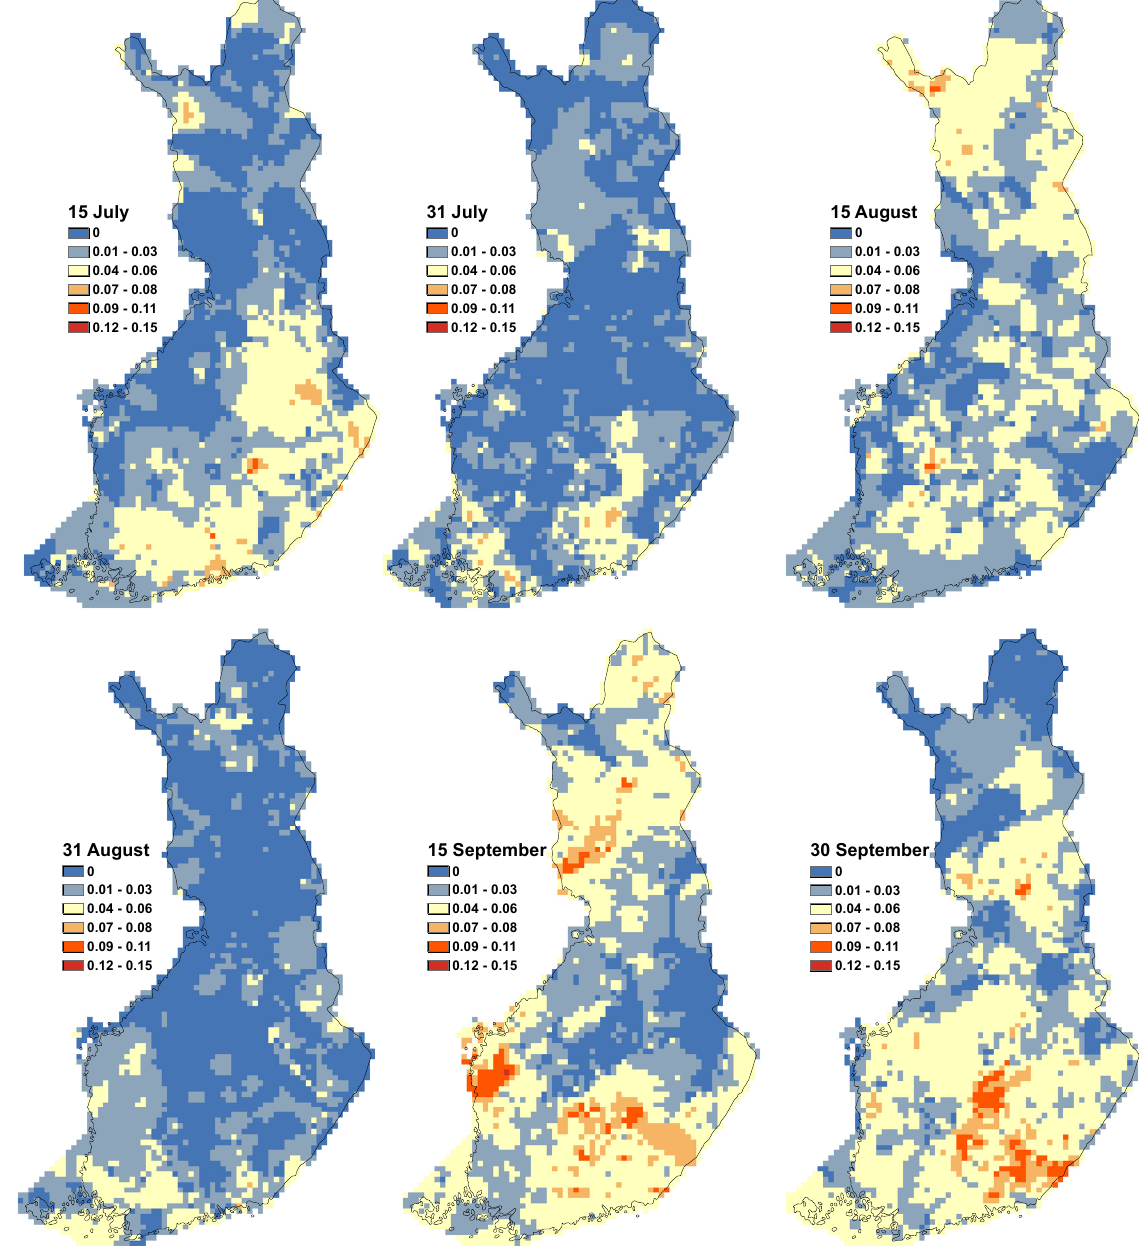
Fig. 3b. Probabilities of repeated rains lasting for at least for two weeks for the periods that ended on 15 July to 30